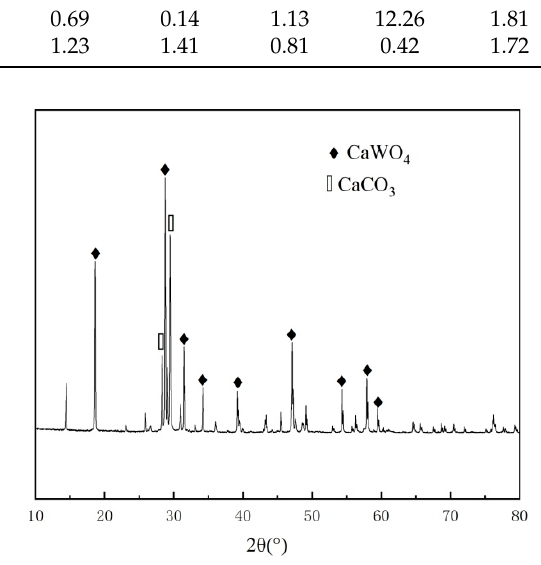
Figure 1. XRD patterns of low-grade scheelite.